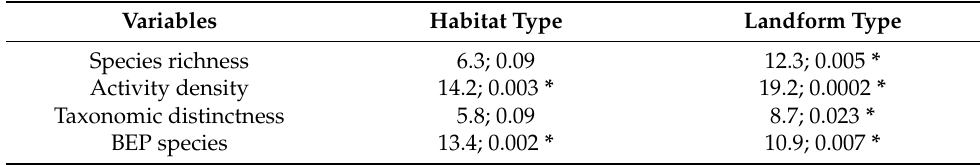
Table 1. Results of the Kruskal–Wallis test (values in the columns: X 2 and p